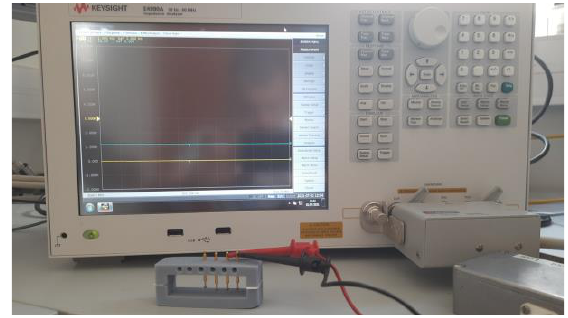
Figure 5 : Instrumentation of impedance meter Keysight